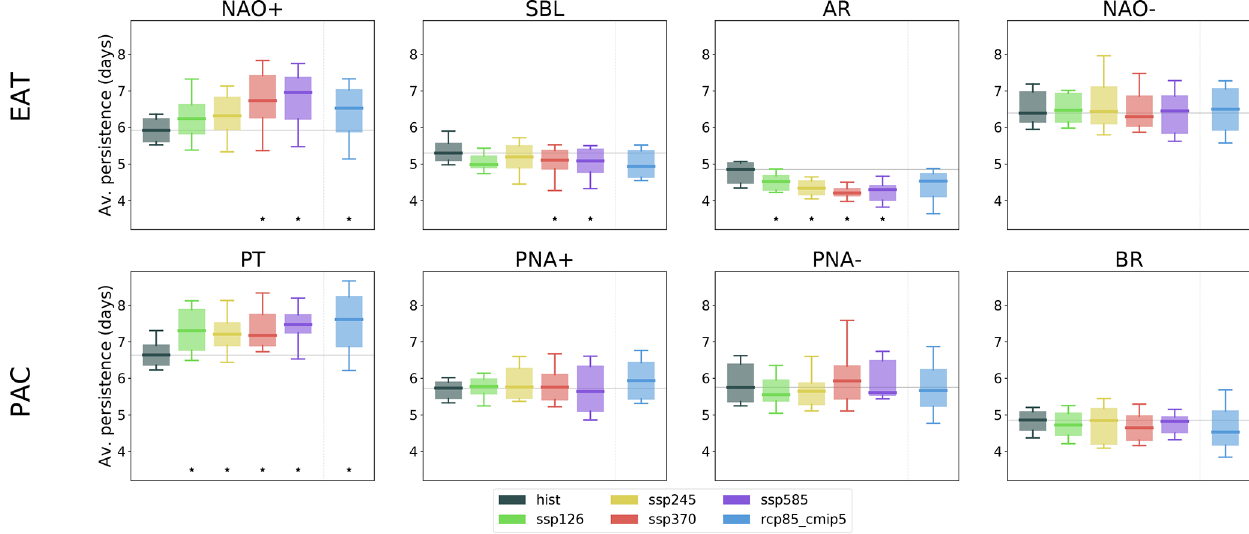
Figure 7. Average regime duration in days for the historical runs and future scenarios. Boxes are defined for the same periods as in Fig. 4, and the black stars at the bottom indicate significant variation with respect to the historical